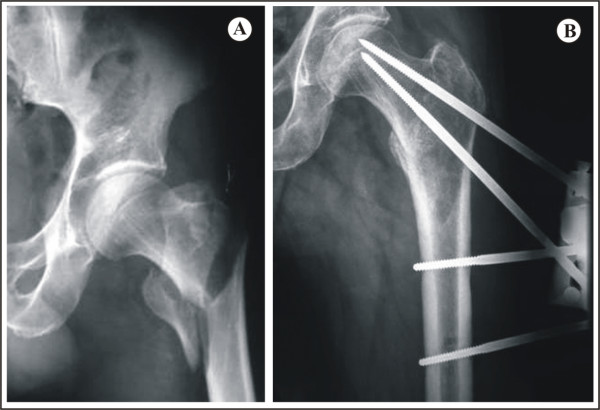
Clinical case with proximal screws placed in a convergent way. A. Anteroposterior view of an AO Type II intertrochanteric fracture in an 82-year old man. B. Anteroposterior view following fixation of the fracture with the fixator applied in a satisfactory position and the proximal screws placed in a convergent way.